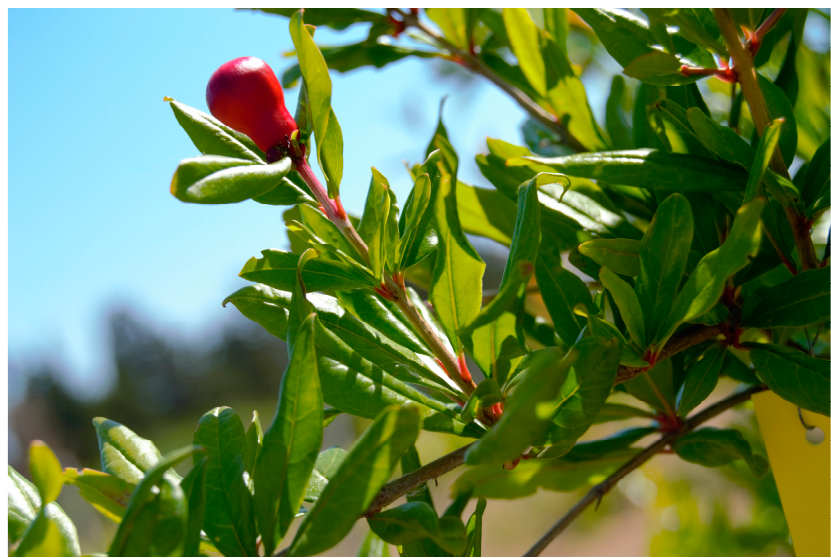
Figure 2. A mixed bud developing a medium shoot with a terminal single flower in ‘Wonderful’.